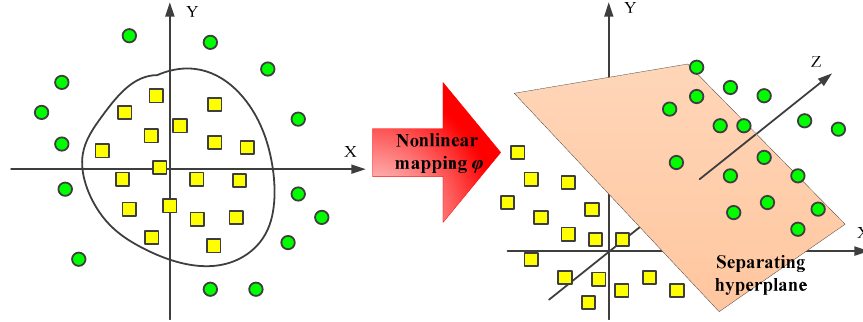
Figure 7. The nonlinear mapping from the input space to a high-dimensional feature space.